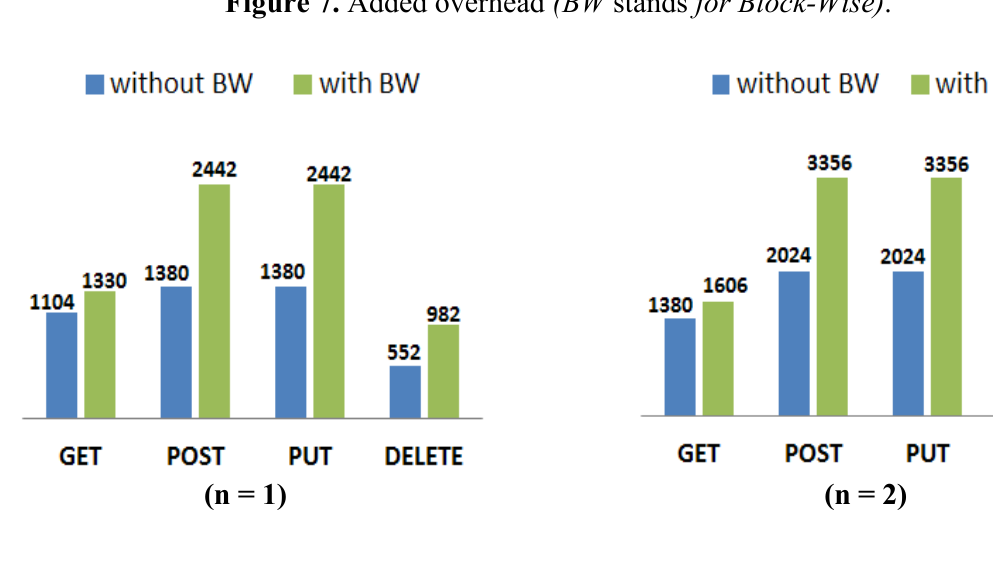
Figure 7. Added overhead (BW stands for Block-Wise)